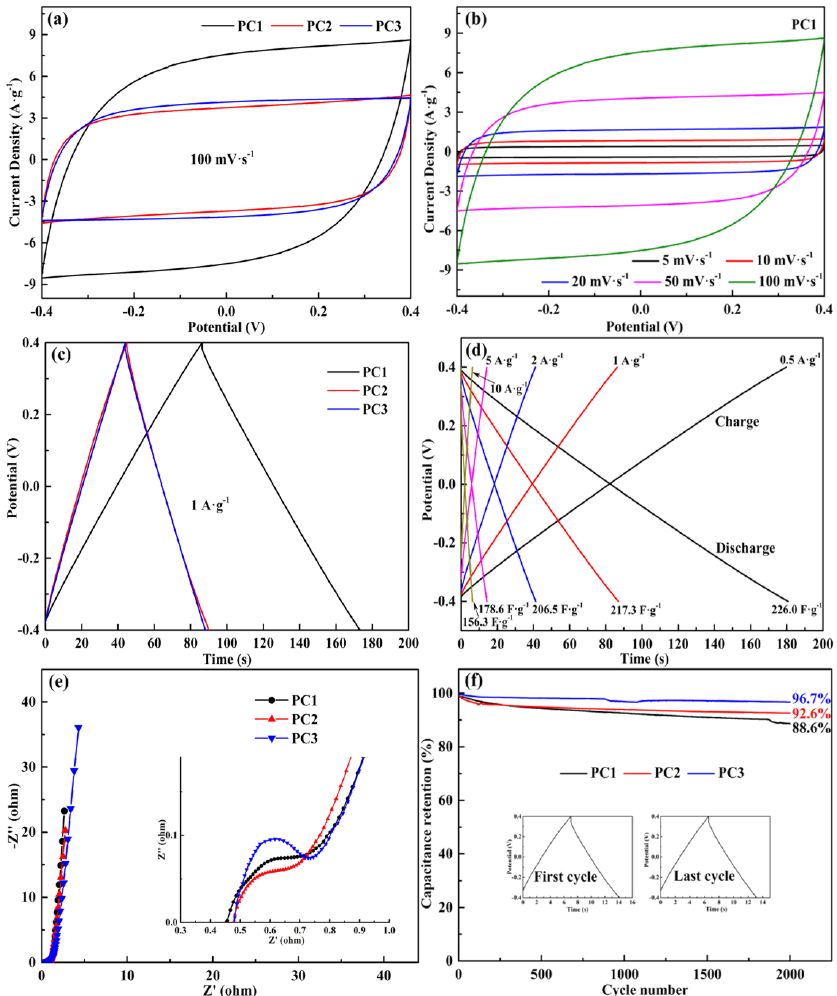
Figure 6. ( a ) The cyclic voltammetry (CV) curves of the PC1, PC2, and PC3 supercapacitors at a scan rate of 100 mV·s −1 ; ( b ) The CV curves of the PC1 supercapacitor at different scan rates; ( c ) The galvanostatic charge/discharge (GCD) curves of the PC1, PC2, and PC3 supercapacitors at a current density of 1 A·g −1 ; ( d ) The GCD curves of the PC1 supercapacitor at different current densities; ( e ) The electrochemical impedance spectra of the PC1, PC2, and PC3 supercapacitors; ( f ) The cycle life of the PC1, PC2, and PC3 supercapacitors at a current density of 5 A·g −1 for 2000 cycles. PC: porous carbon. Figure 6e shows the Nyquist plots of all the three supercapacitors with inset showing the high- frequency region. All the supercapacitors exhibited low ESR values (0.43–0.47Ω), which is mainly attributed to the high content of oxygen heteroatom and hierarchical porous structure in PCs [57]. Moreover, it has been proved that electrolyte ions can be transported and diffused rapidly in PCs. All the curves deviated from Y -axis in the low-frequency region, which indicates that the